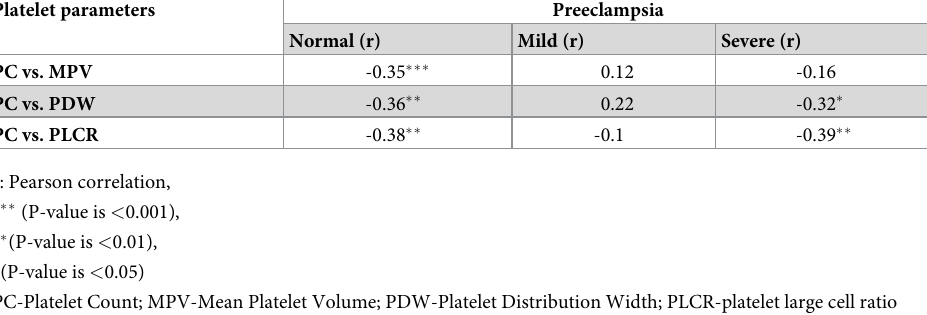
Mean (Standard Deviation); F-test (One way-Anova) for mean rank difference across severity of PE; PC-Platelet Count; MPV-Mean Platelet Volume; PDW-Platelet Distribution Width; PLCR-platelet large cell ratio; fl- femtolitre. � (P-value is < 0.001).